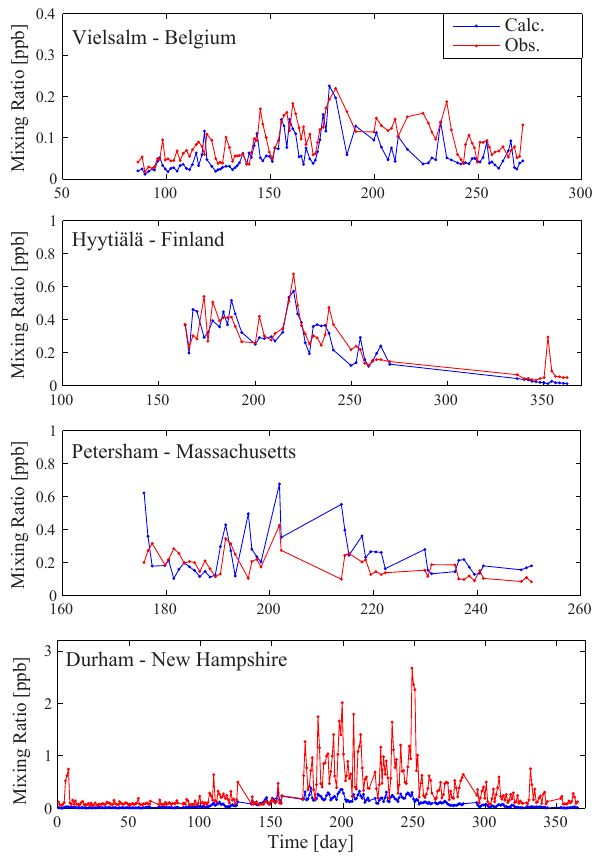
Fig. 3. Validation of the DEHM model results of daily average monoterpene mixing ratios against measurements from the sites in Belgium, Finland, Massachusetts and New Hampshire for the years 2010, 2006, 2005 and 2008